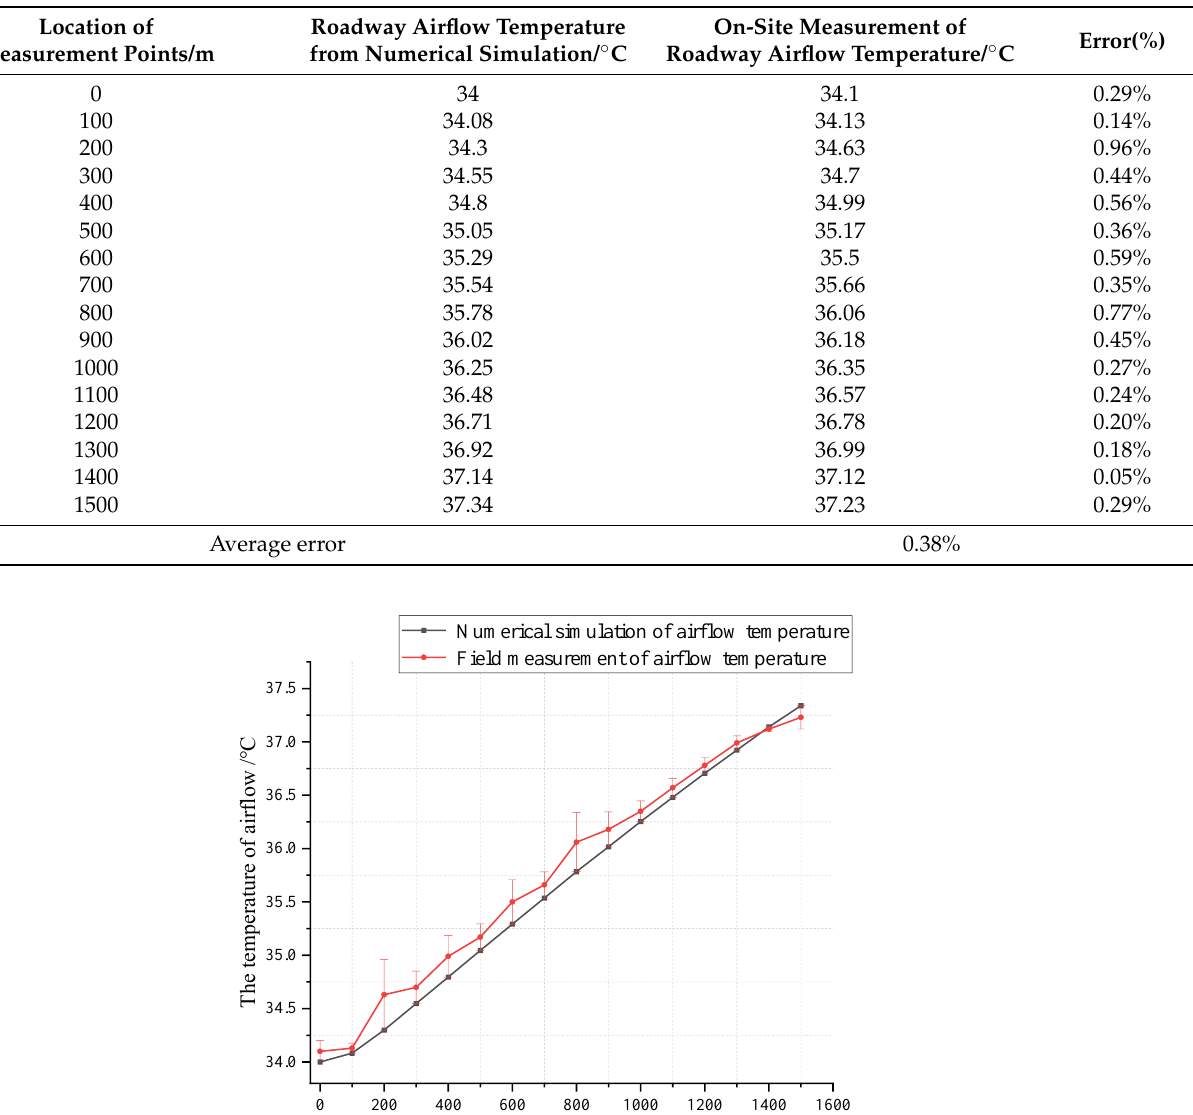
Table 4. Numerical simulation and field measurement of roadway airflow temperature and the error between them. Location of Measure-